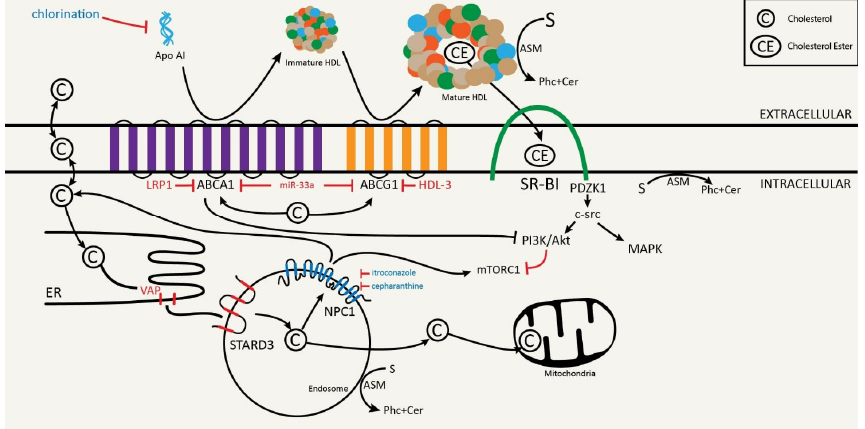
Figure 1. The interplay of common cholesterol efflux factors and their relationship with selected chemotherapeutic agents. Cholesterol (C) can be effluxed from the cell via a variety of mechanisms including passive diffusion, SR-B1-facilitated diffusion, ABCA1 active reflux, and ABCG1-mediated efflux. Apo AI together with ABCA1 provides the rate-limiting step of RCT, with ABCG1 assisting in HDL lipidation. Both ABCA1 and ABCG1 are regulated by miR-33a. SR-B1 is able to bind HDL molecules and remove cholesterol esters from the HDL molecule for intracellular transport. Downstream effects of SR-B1 activity shows enhanced cellular proliferation and migration through MAPK and PI3K/Akt pathways, with the latter being shown to downregulate the mTORC1 pathway. Cholesterol movement involving cellular endosomes has been shown to be regulated by STARD3 and NPC1. STARD3 complexes with VAP on the ER to allow for cholesterol movement from the ER into the endosome, and has been shown to further move this cholesterol into the mitochondria for steroidogenesis. NPC1 mediates cholesterol efflux from the endosome, and has been shown to upregulate the mTORC1 pathway in the process. ASM, coded for by the SMPD1 gene, is found on HDL molecules, the plasma membrane, and cellular endosomes. ASM serves to convert sphingomyelin (S), formed in part by cholesterol, into phosphorylcholine (Phc) and ceramide (Cer). Int. J. Mol. Sci. 2021 , 22 , x FOR PEER REVIEW